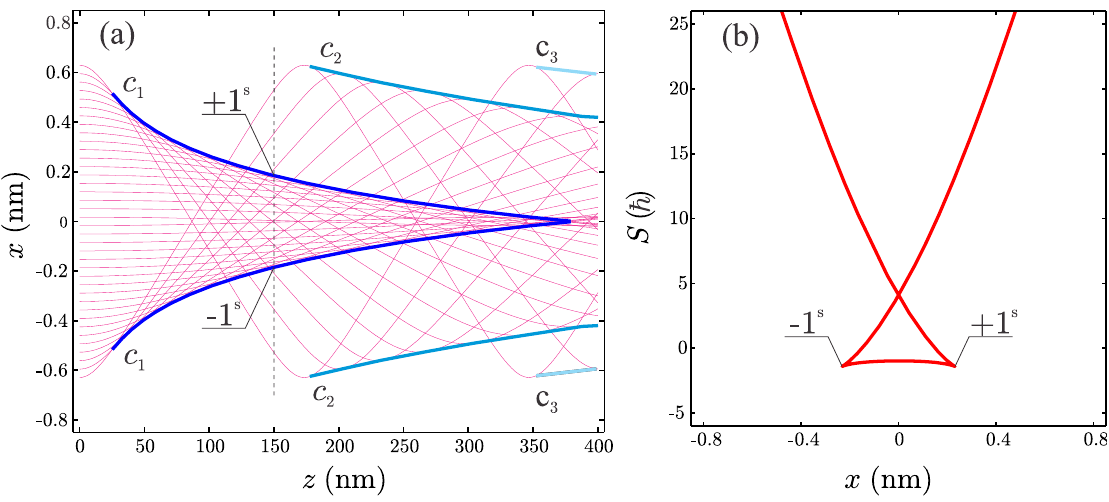
Figure 10. ( a ) Trajectories of the 1MeV positrons (magenta lines) in the xOz plane and associated envelope lines (blue hue lines). ( b ) Corresponding Hamilton’s principal function at the z = 150